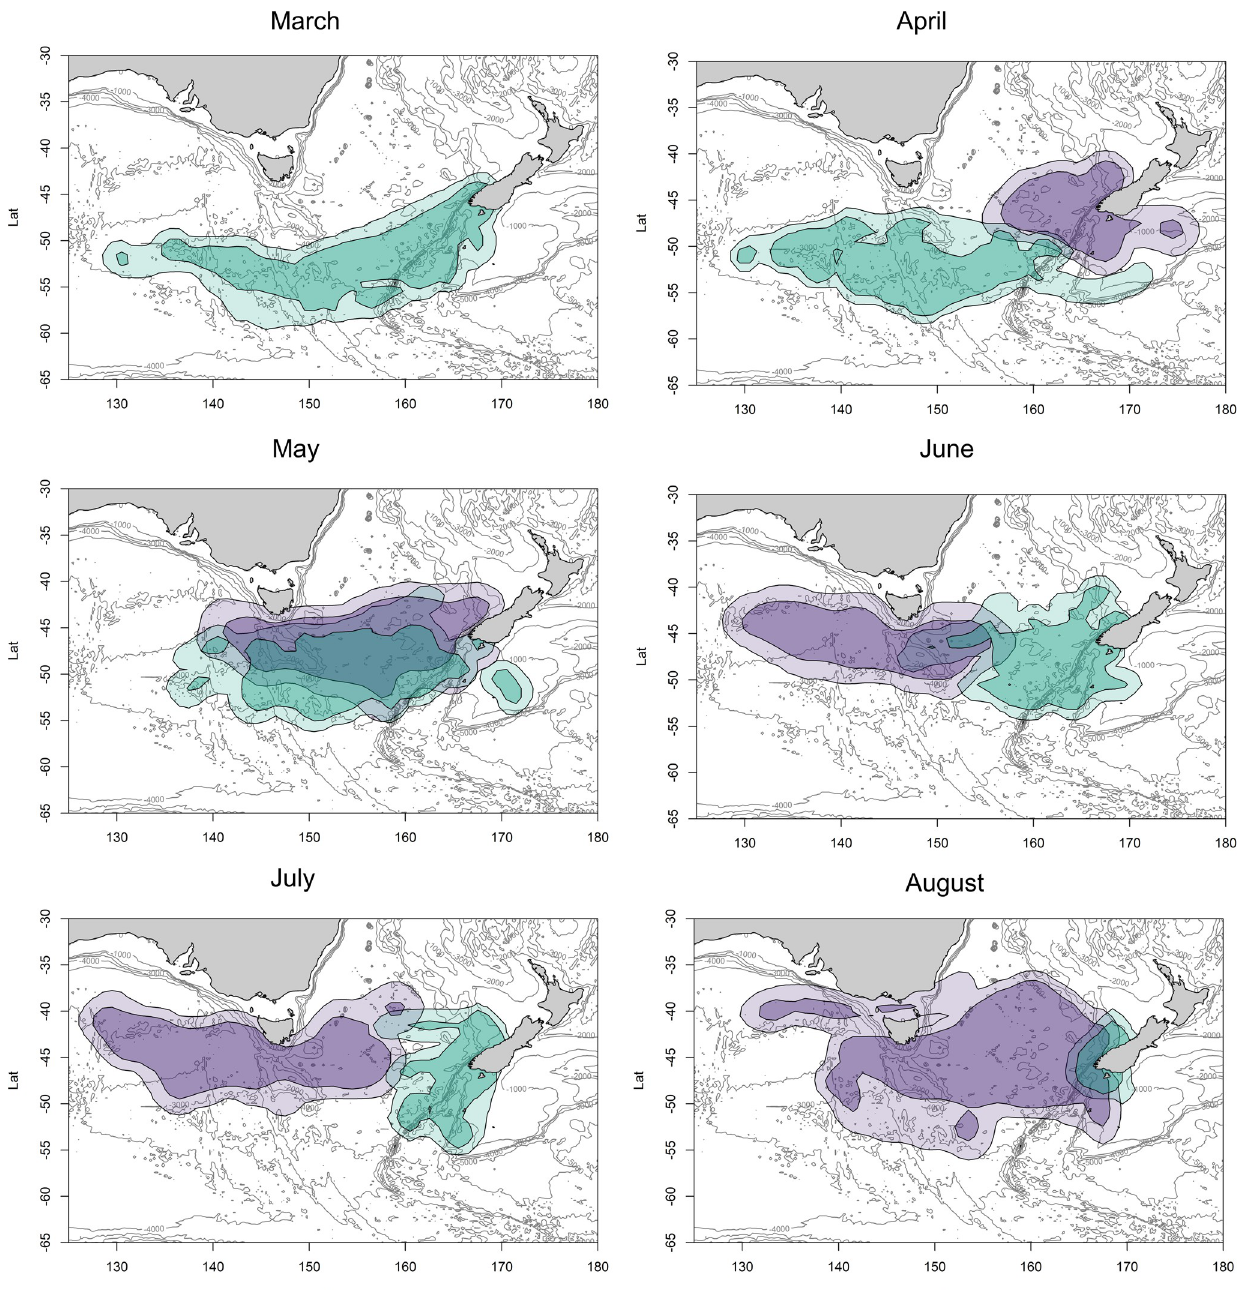
Fig 5. The core (50% UD) and peripheral (90% UD) non-breeding distributions for Snares (purple) and Fiordland (turquoise) penguins. February (the month when the Fiordland penguins first set out) and September (when the Snares penguins return to their colonies) were excluded as they only represented one week of data